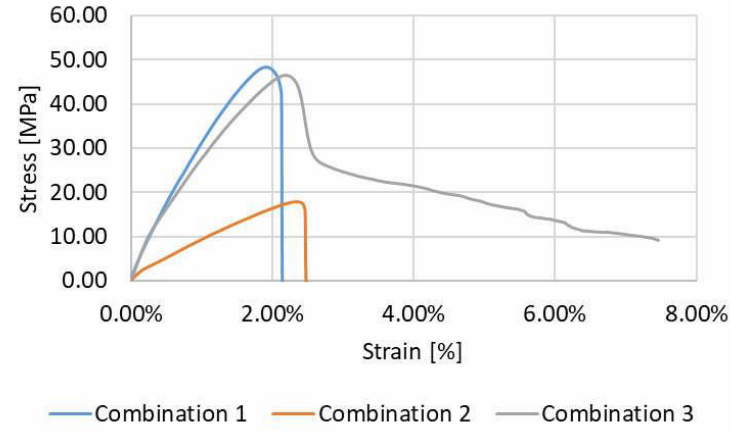
Figure 11. Optimum combinations of tensile strength.